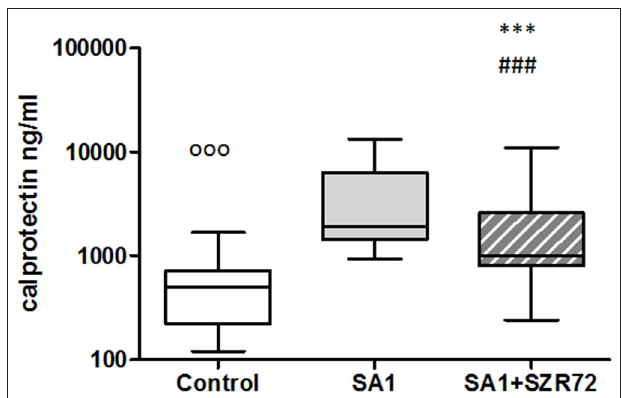
FIGURE 6 | The effect of KYNA analog, SZR72 on calprotectin production in human whole blood cells of normal donors stimulated by heat-inactivated Staphylococcus aureus. Ethylenediaminetetraacetic acid (EDTA)-anticoagulated blood samples 1–1ml from each of 50 normal blood donors were incubated with SZR72 at a concentration of 500 µ m for 30min prior to the addition of heat-inactivated Staphylococcus aureus (10 7 /ml). The concentrations of calprotectin in the plasma were determined after an 18 h-incubation period. The data are depicted as box and whiskers plots, where the lines inside the boxes denote medians, and the boxes mark the interval between 25 and 75 percentiles, and the whiskers, the maximum and minimum. Significance was determined by the Friedman’s test. Control vs. SA1, ooo p < 0.001; control vs. SA1 + SZR72, ### p < 0.001; SA1 vs. SA1 + SZR72, *** p < 0.001, according to the Dunn’s post-test.